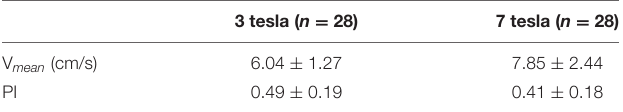
TABLE 3 | Perforating artery flow at 3 and 7 tesla MRI in case of vessel matching by